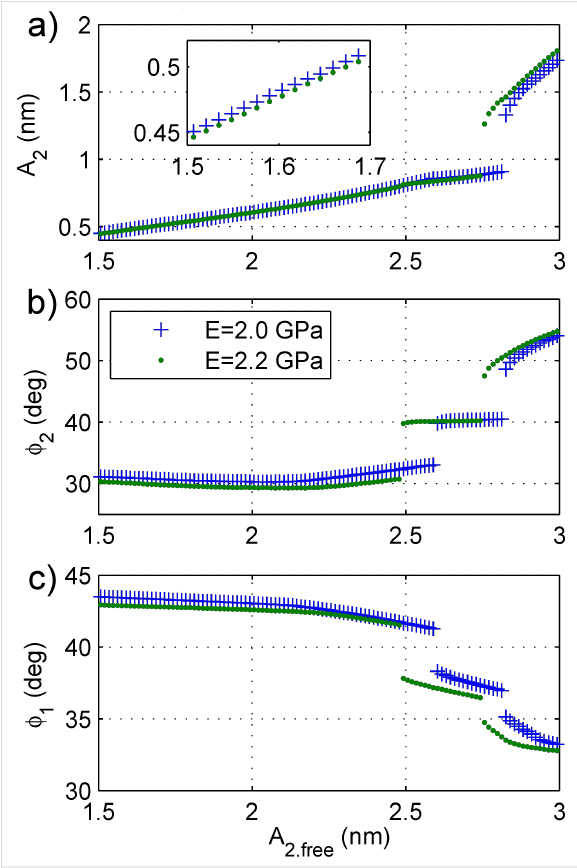
Figure 6: A drive amplitude sweep similar to Figure 5 except that two different materials are compared (both are sweeps from high ampli- tude down to low amplitude). The transitions between the different states happen at slightly different amplitudes for each material. It is clear from (a) and (b) that the contrast reversal observed in Figure 1, Figure 2, and Figure 4 is caused by the transition from one state to another. That is, in the state on the left (low A 2,init ), A 2 and on the stiffer material are higher than A 2 and on the softer material. But, in the state on the right (high A 2,init ), A 2 and on the stiffer material are lower than A 2 and on the softer material. The middle state appears to have very little contrast between the two materials. Finally, drops as A 2,init is raised, with big drops at each state